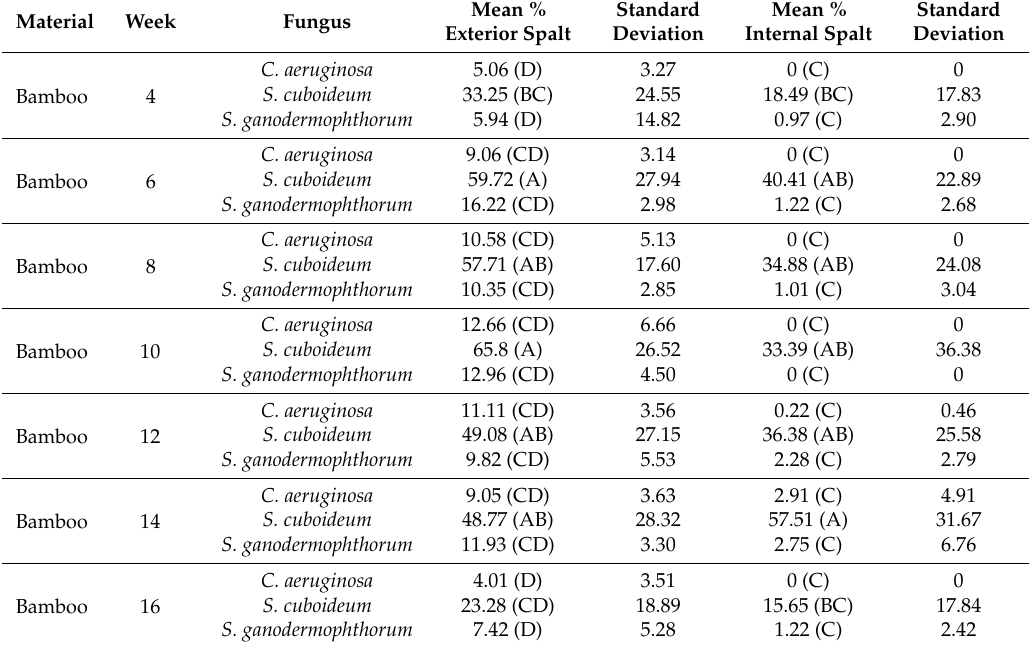
Table 1. Mean area coverage of the external and internal surfaces of the bamboo blocks with natural spalting. Different letters classify the data as statistically different within each pigment color.